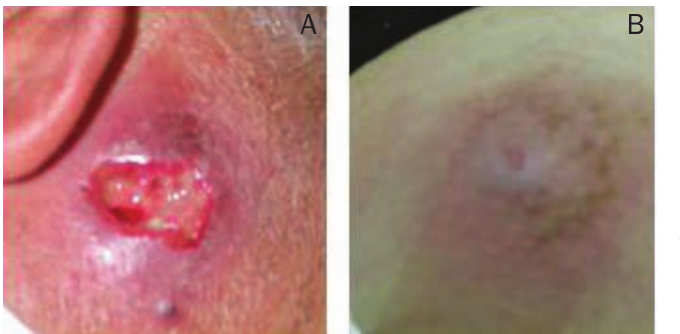
Figure 1. (A) Painful ulcerat- ed nodules on the neck. (B) A painful abscess with associated erythema and edema of the right